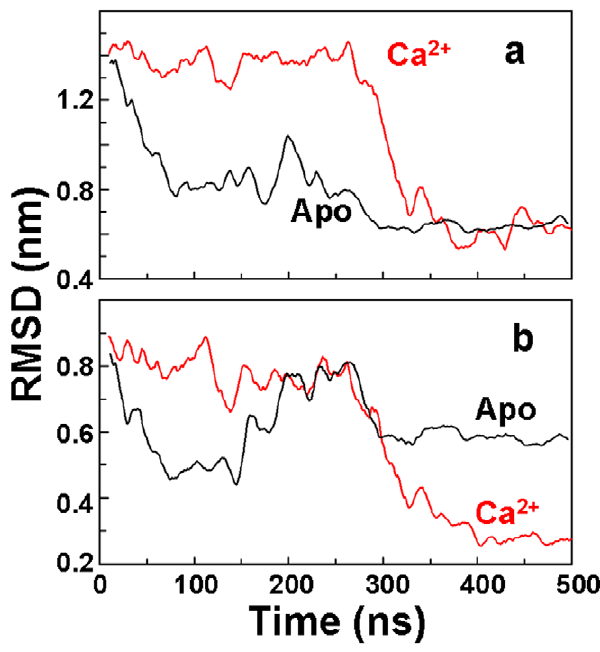
Figure 4. Geometrical rearrangement of the cytosolic head- piece of SERCA. ( a ) RMSD of the entire headpiece of Ca 2 + -bound ( red ) and Apo (black) SERCA; ( b ) RMSD calculated for the N and P domains only in the trajectories of Ca 2 + -bound (red) and Apo ( black ) SERCA. RMSD was calculated by superimposing the backbone atoms of domains N, P and A or N and P, respectively, onto the closed crystal structure of SERCA bound to Ca 2 + and AMPPCP (PDB: 1vfp). Low RMSD values indicate similarity to the crystal structure.